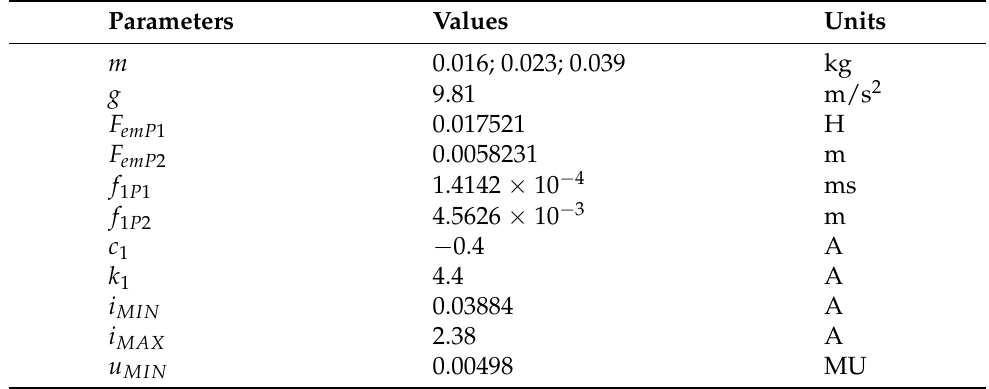
Table 1. ML plant parameters used in nonlinear state model.